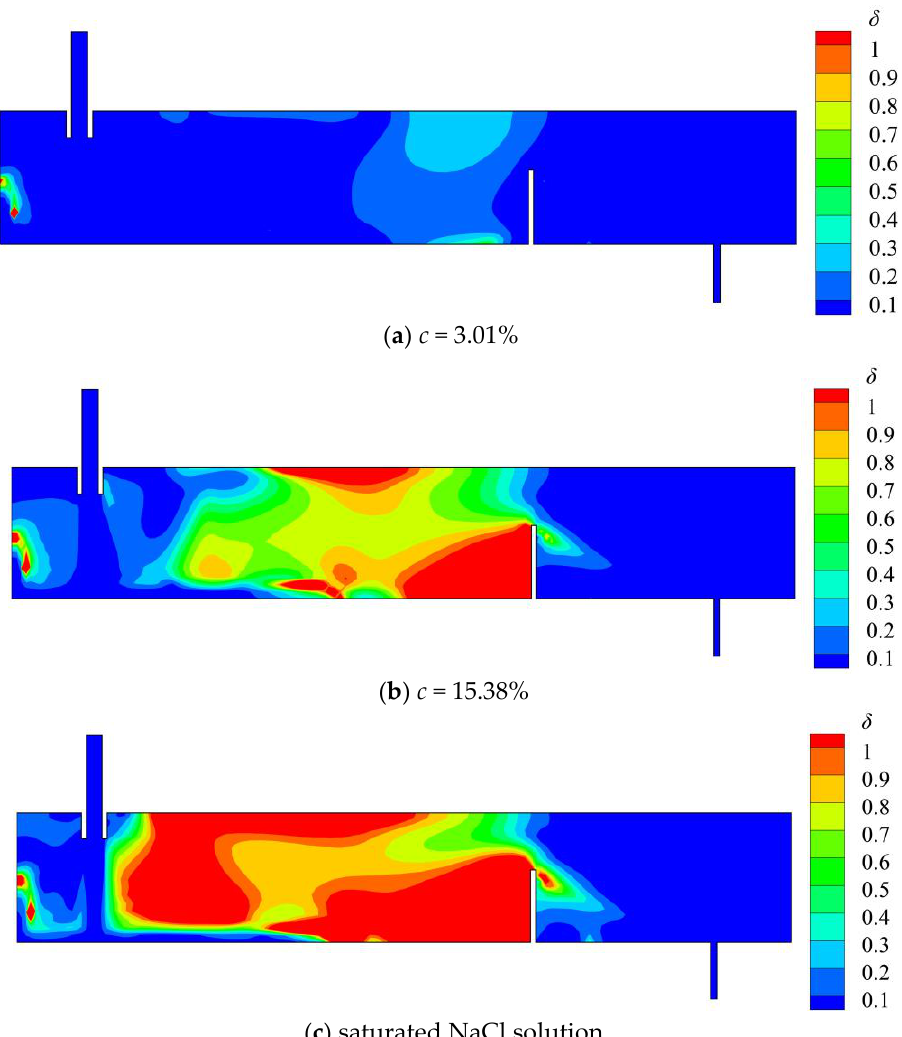
Figure 13. The distribution of velocity difference number δ in tundish at 25 s: (a) c = 3.01%; (b) c = 15.38%; (c) saturated NaCl solution.